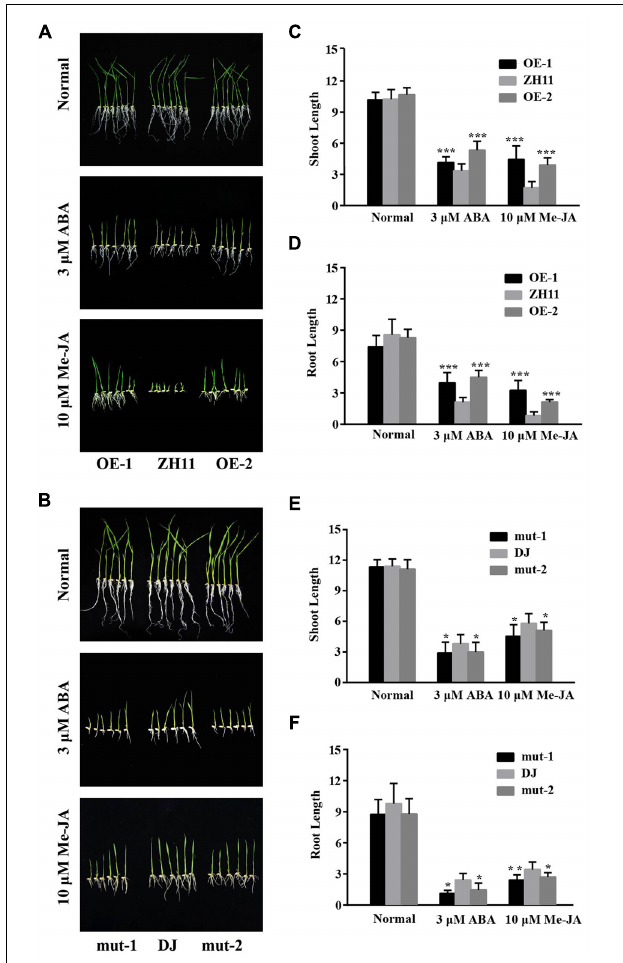
FIGURE 4 | ABA and MeJA sensitivity assay of the OsJAZ1 -OE and T-DNA mutant plants. (A,B) The OE lines and the mutant lines were treated with 3 µ M ABA and 10 µ M MeJA, under normal conditions (no addition of ABA or MeJA) as a control. (C–F) Shoot and root length of the seedlings were measured to estimate the sensitivity of the WT and transgenic plants. Error bars represent the SE of three replicates ( ∗∗∗ P < 0.005, ∗∗ P < 0.01, ∗ P < 0.05, Student’s t